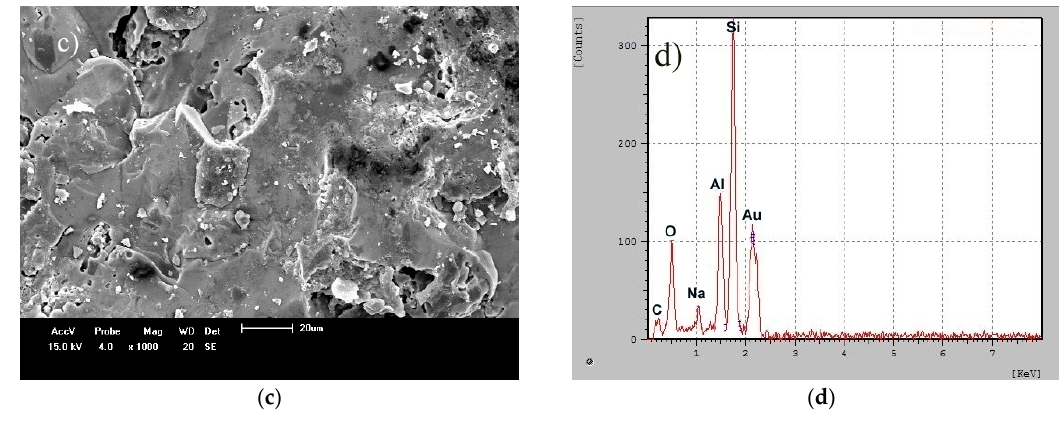
Figure 3. SEM micrographs of the fracture surfaces of the ML3 formulation fired at various temperatures: ( a ) 1190 °C; ( b ) 1230 °C; ( c ) 1250 °C; and ( d ) SEM/EDS spectrum at 1250 °C.